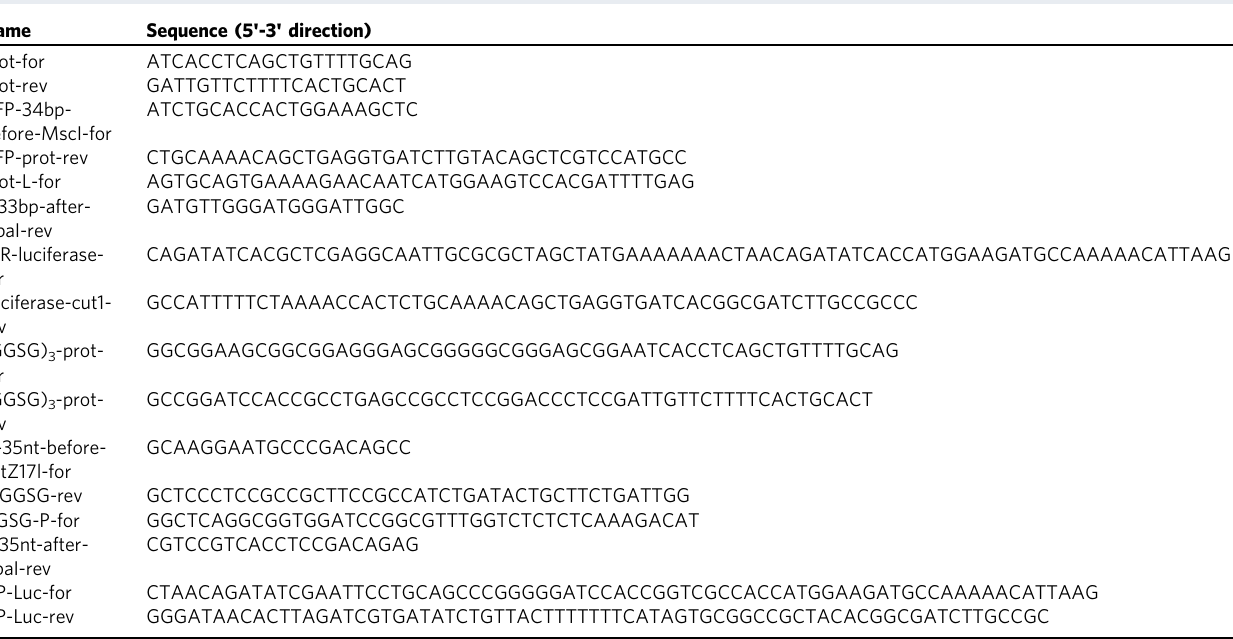
Table 1 cloning primer for VSV